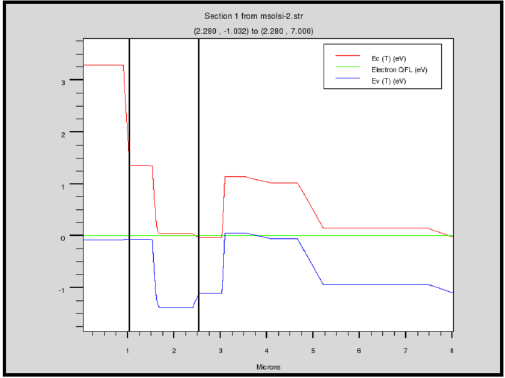
Fig. 4. SILVACO description of the MultiSolSi schematic tandem solar cell structure showing net doping densities.